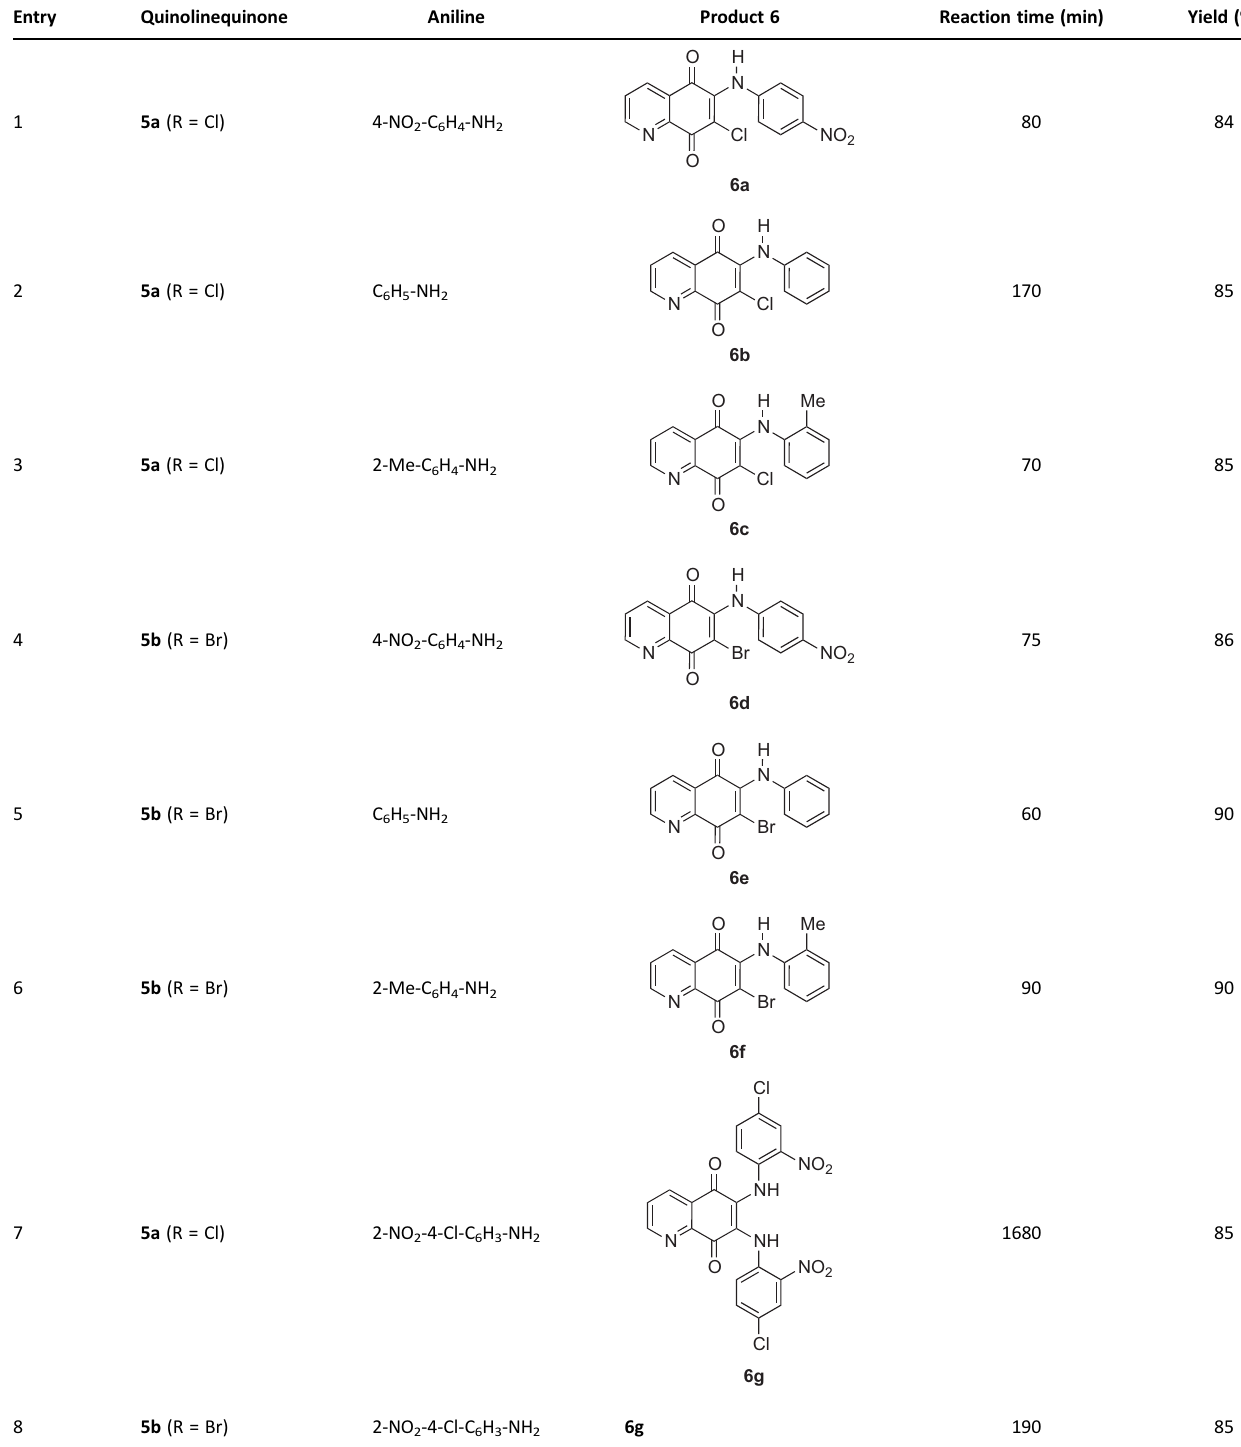
Table 2 . Amination of 6,7-disubstituted-5,8-quinolinequinones with different aniline derivatives. Entry